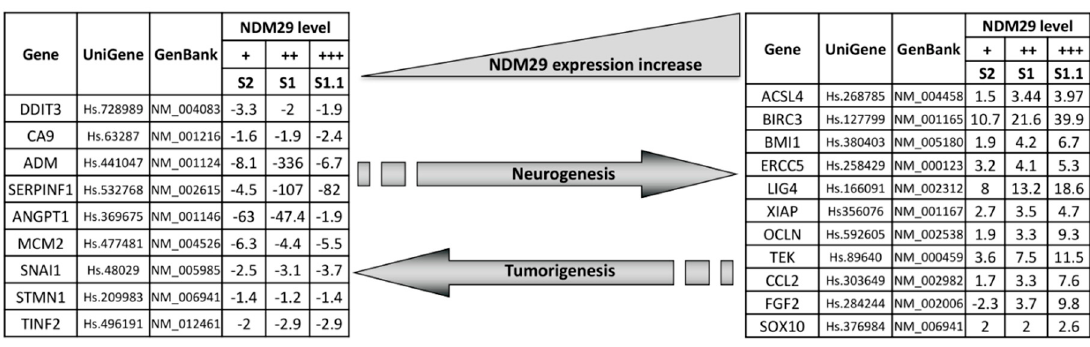
Figure 1. NDM29-driven differentiation of neuroblastoma cells The expression of neuron-specific protein markers in NDM29-overexpressing cells was evaluated by IF: ( A ) Nestin, NES; ( B ) Tubulin β 3 Class III; TUB β 3, ( C ) Doublecortin, DCX and ( D ) Microtubule Associated Protein 2, MAP2 were detected and their relative fluorescence intensity was calculated (see Material and Methods Section), scale bars 20 µm; ( E ) Decrease of colony forming showing the progressive lack of malignancy from Mock to S 1.1 cells cultured in the presence of morphogens. Statistical analysis was performed excluding S1.1M cells that did not form colonies in methylcellulose; ( F ) The increase of population doubling-time correlates to the increase of NDM29 expression level. Statistical analysis was performed excluding S1.1M cells because of their fully mature, non-proliferating stage; ( G ) FACS analysis of GD2 + cells in different cell populations shows a linear reduction of GD2 + cells in clones overexpressing NDM29 ncRNA. Statistical significance is displayed as p < 0.05 (*), p < 0.01 (**).